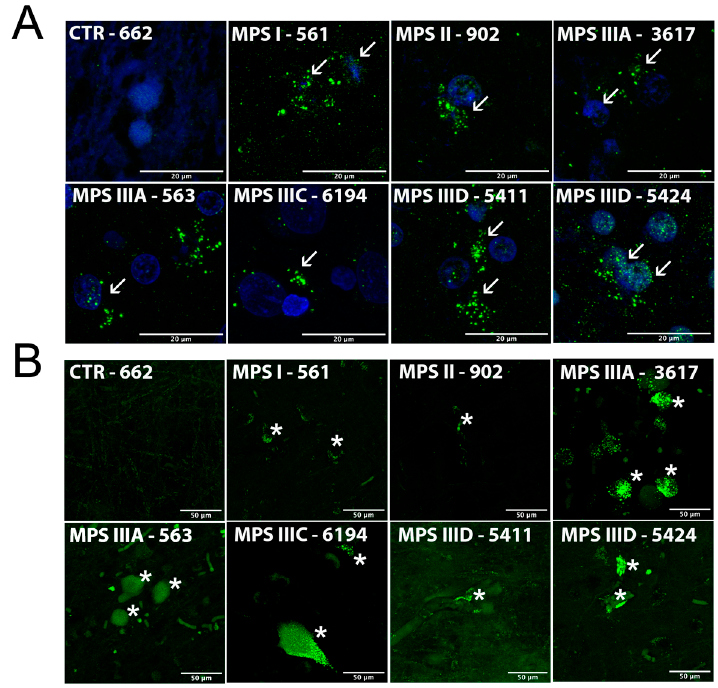
Figure 4. Impaired autophagic flux and accumulation of misfolded proteins in brain cortex tissues of human MPS patients. Representative confocal microscopy images showing ( A ) accumulation of light chain 3B protein (LC3B)-positive puncta (green) and ( B ) thioflavin S-positive protein aggregates (green) in brain cortex tissues from MPS I (561), MPS II (902), MPSIIIA (3617 and 563), MPS IIIC (6194), and MPS IIID (5411 and 5424) patients and a representative control (662). The fixed brain tissues of the MPS II patient HBCB1801OC were not sufficiently preserved to perform cryosectioning and conduct immunofluorescent analysis. DAPI (blue) was used as the nuclear counterstain. Neurons with LC3B puncta are marked with arrowheads and those stained with thioflavin S are markedwith asterisks. Scale bars: 20 μ m ( A ) and 50 μ m ( B ).